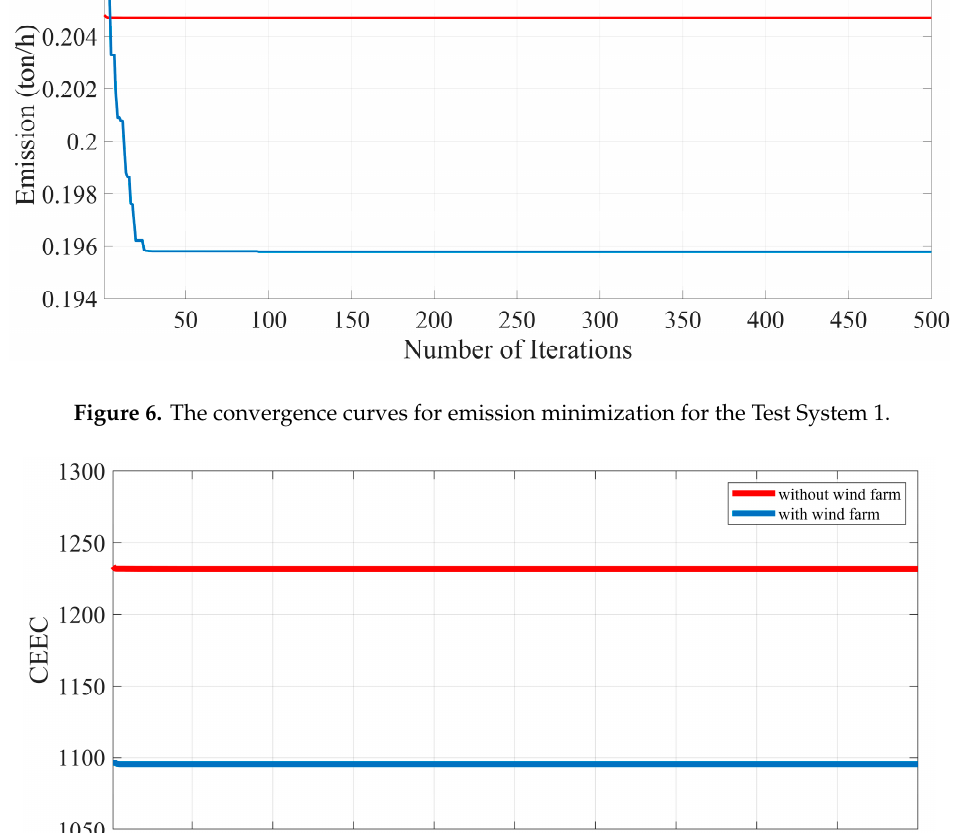
Figure 7. The convergence curves for CEEC minimization for the Test System 1.